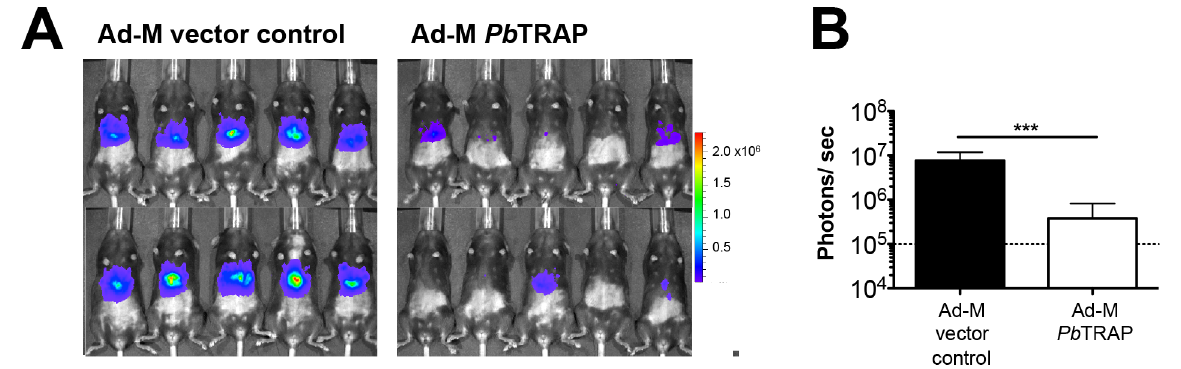
Figure 7. Protective efficacy against sporozoite challenge in Ad-M Pb TRAP-immunized mice. Mice immunised with Ad-M Pb TRAP (or Ad- M vector control) were challenged with 5 6 10 3 Pb GFP-Luc con sporozoites ( A ) Imaging of mice 40 hours after challenge and after subcutaneous injection with D-luciferin. ( B ) Quantification of parasite development (***p , 0.001, Mann-Whitney test). Dotted lines represent baseline measurement of livers from naı¨ve mice. Figures are representative data from one of 4 experiments with 5 mice/group/experiment.